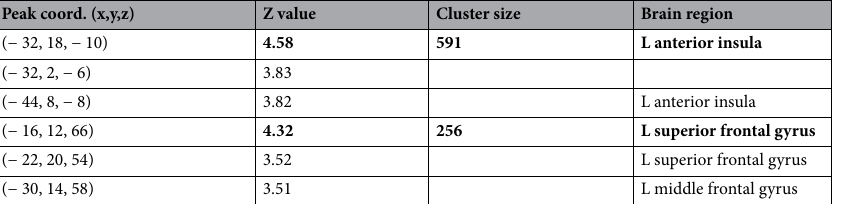
Table 4. Maxima of brain regions (MNI coordinates) for the increased neural activity for the processing of object-before-subject word order (OVAS > SVAO) with increasing hearing loss (PTA-high; L = Left; Family- Wise Error corrected on the cluster level, threshold of p < 0.05).